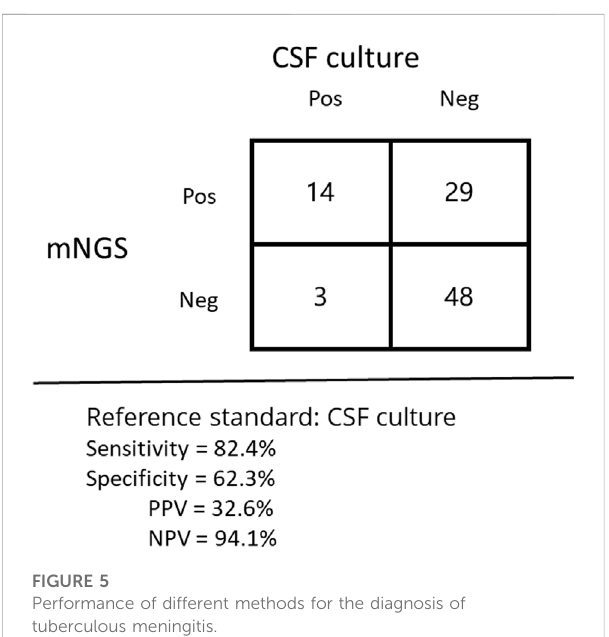
FIGURE 5 Performance of different methods for the diagnosis of tuberculous meningitis.